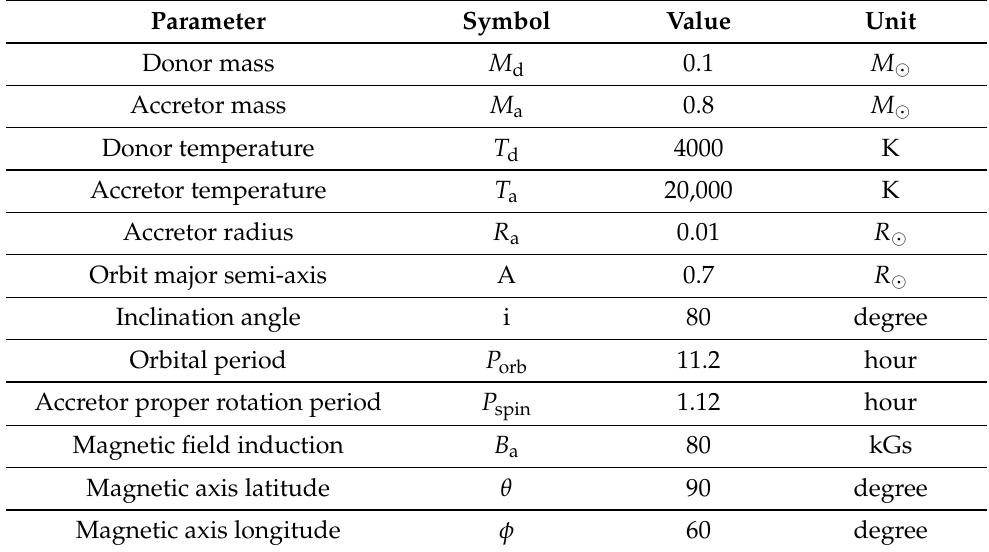
Table 1. The initial parameters for numerical simulation of the intermediate polar EX Hya.